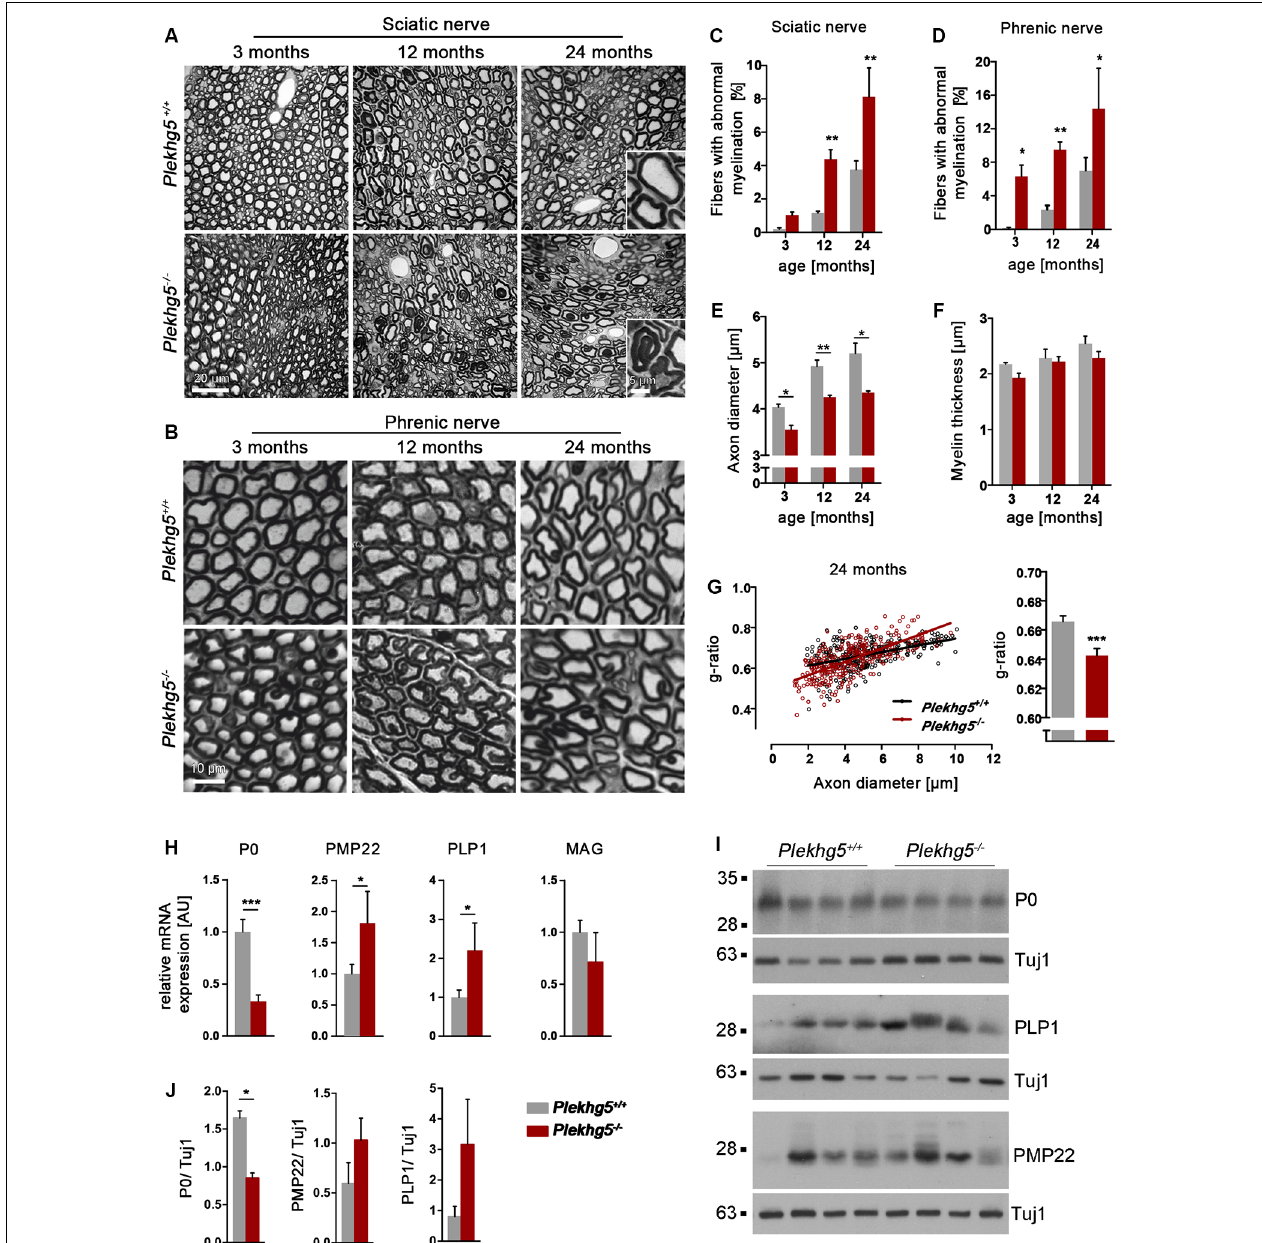
FIGURE 1 | Histopathological analysis of peripheral nerves. (A,B) Semithin sections of the sciatic (A) and phrenic (B) nerve of wild-type ( Plekhg5 +/+ ) and mutant mice ( Plekhg5 − / − ) at different ages. Note numerous myelination defects in mutant mice. Scale bars: (A) 20 µ m and 5 µ m (blow-up), (B) 5 µ m. (C,D) Relative amount of axons with myelin alterations. Five animals per genotype and age ( n = 5, unpaired, two-tailed t -test). (E) Mean axonal diameter of wild-type and mutant mice at different ages. Three animals per genotype and age ( n = 3, unpaired, two-tailed t -test), 100 axons/animal. (F) Mean myelin thickness of wild-type and mutant mice at different ages. Three animals per genotype and age ( n = 3, unpaired, two-tailed t -test), 100 axons/animal. (G) G-ratio analysis of 24-month-old mice. Three animals per age and genotype, 100 axons/animal. (H) qPCR analysis of several myelin genes within the sciatic nerve of wild-type and mutant mice at an age of 10 months [ n = 5/6 (wild-type/ko), unpaired, two-tailed t -test]. The mean expression of the two housekeeping genes Ppia and Eef2 was used as internal control. (I) Protein levels of P0, PMP22, and PLP1 in sciatic nerve lysates obtained from 11-month-old mice. (J) Quantification of Western blots [ n = 5/4 (wild-type/ko), unpaired, two-tailed t -test]. * p < 0.05; ** p < 0.01; *** p <